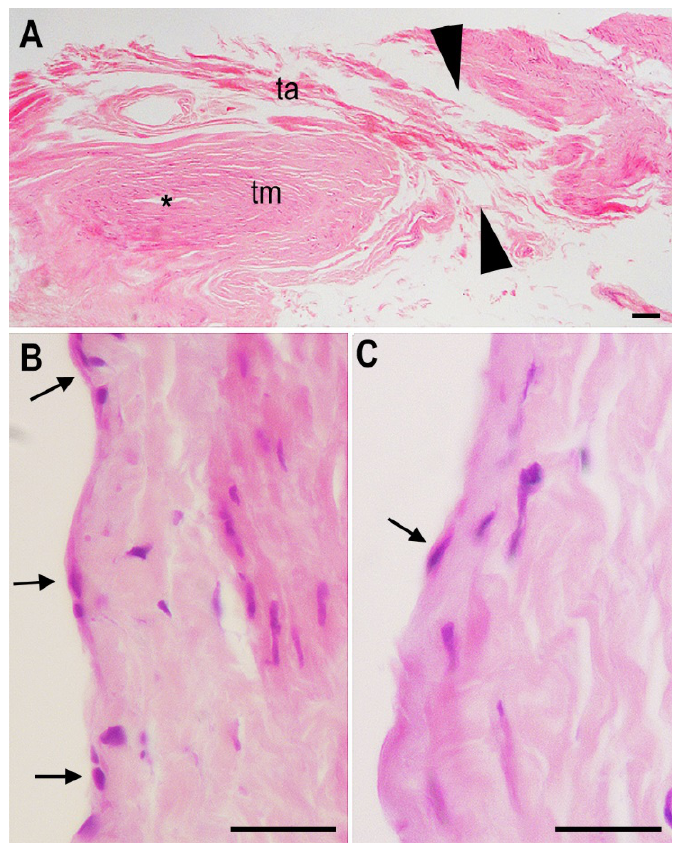
Figure 3. Representative histological features of the saphenous vein specimens after long-term incubation, freezing and thawing. ( A ) Longitudinal section across the surgical wound, indicated by arrowheads; asterisk: lumen, tm: tunica media, ta: tunica adventitia. ( B ) High magnification of a vein specimen incubated in enriched medium showing a nearly continuous layer of endothelial cells (arrows). ( C ) Same magnification of a vein specimen incubated in non-enriched medium showing diffuse endothelial loss, with only scattered residual endothelial cells (arrow). H&E staining; bars = 100 µm .